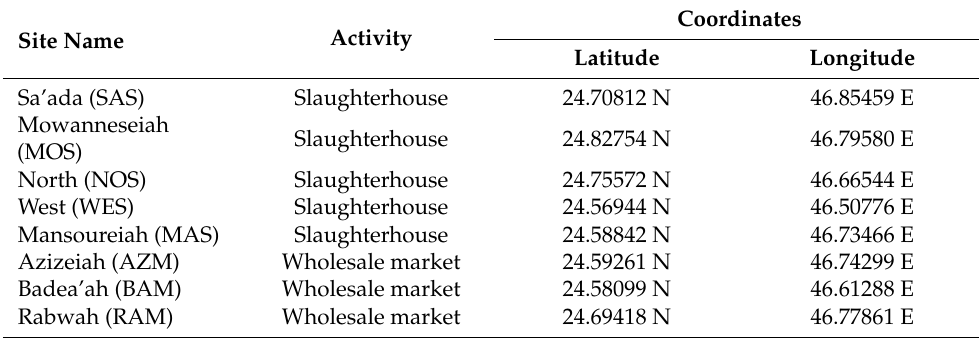
Table 1. Collection sites of house fly field populations in Riyadh city.